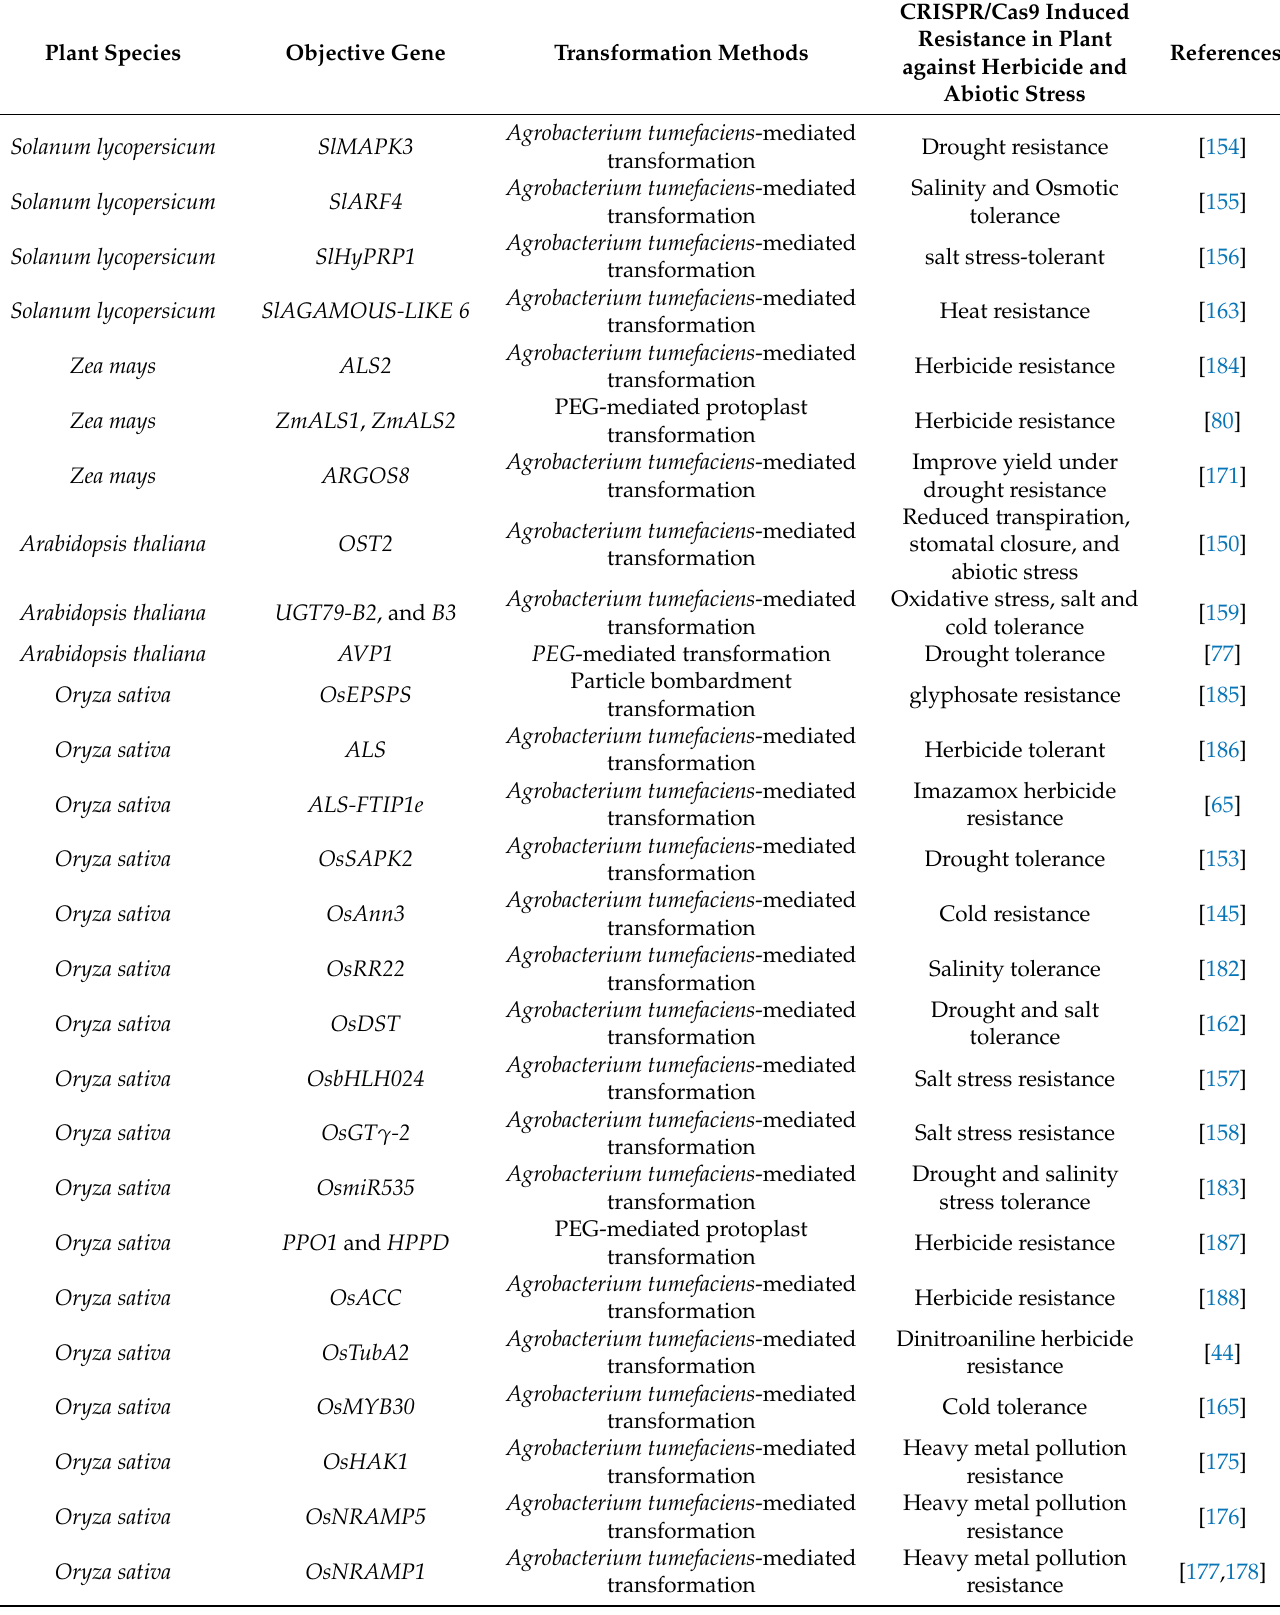
Table 3. CRISPR/Cas induced resistance against abiotic